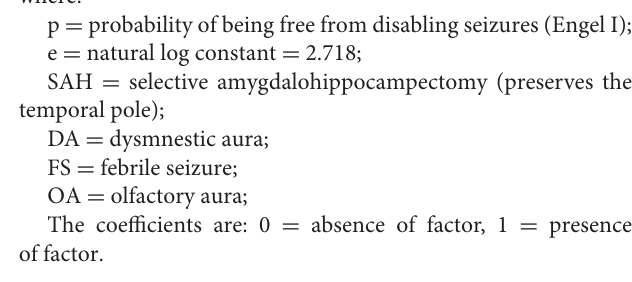
(c) presence of an IPI (such as prolonged non-febrile seizure, status epilepticus, trauma brain injury, obstetric complications); (d) family history of febrile seizures; (e) family history of epilepsy; (f) presence of a focal neurological deficit; (g) lateralization signs in semiological, interictal, and ictal EEG; (h) having performed an invasive evaluation, and (i) side of surgery. Complications Five hundred and forty patients had no immediate complications (87%; 95% CI : 84.1–89.5) and 537 patients had no late postoperative complications (86.5%; 95% CI : 83.5–89.1). The most common late complication was chronic headache